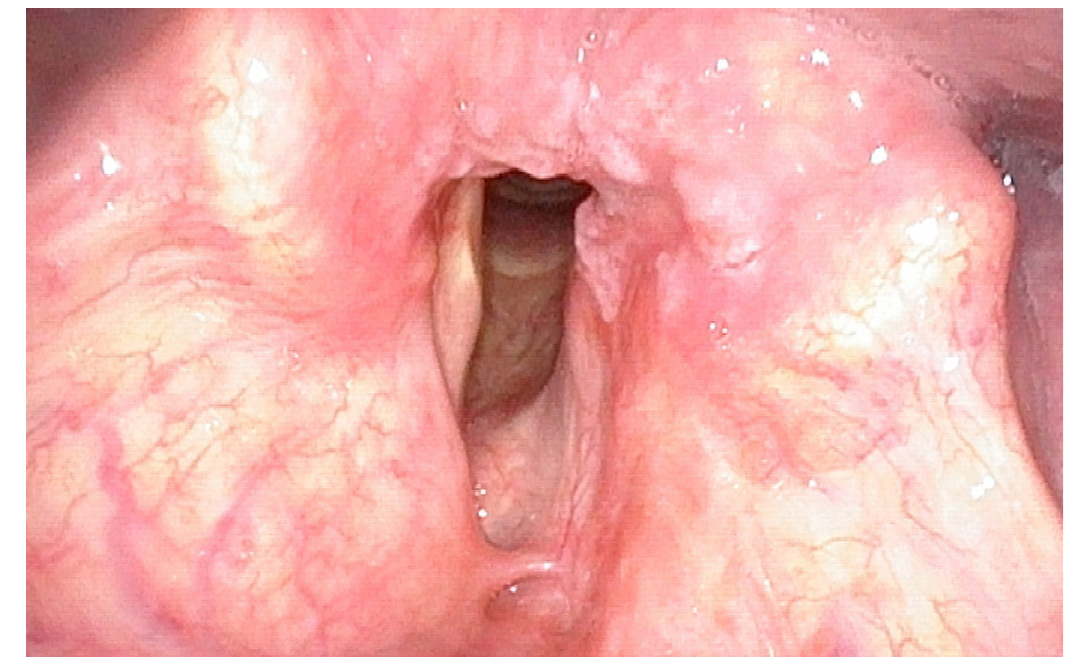
Fig 2. Mucosa assessed in conventional white-light